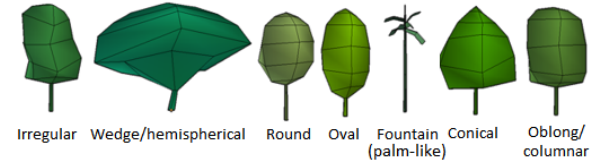
Figure 14. Tree shape typologies for LOD2 representation